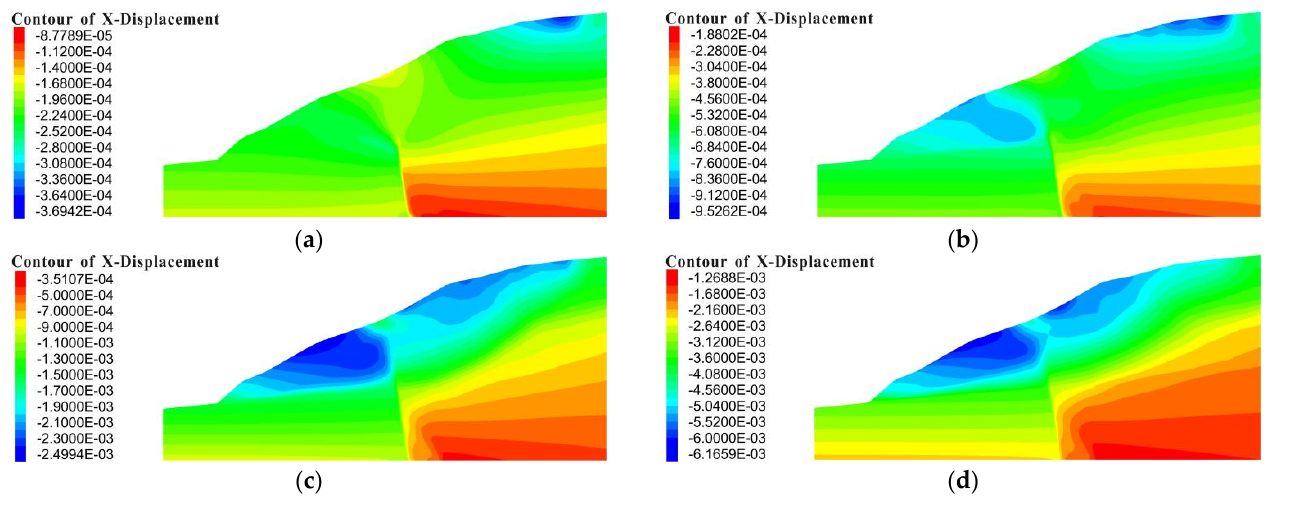
Figure 19. Permanent displacement in the model slope with an HADAFZ at input PGA of ( a ) a = 0.1 g, ( b ) a = 0.2 g, ( c ) a = 0.3 g, and ( d ) a = 0.4 g (unit: m).